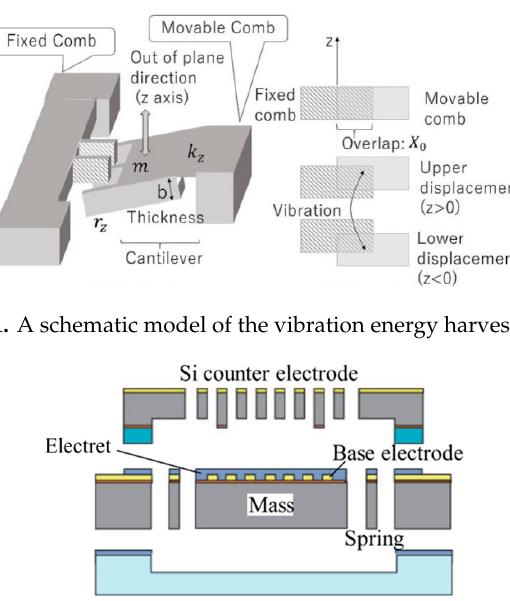
Figure 2. Cross-sectional view of microelectromechanical systems (MEMS) vibration energy harvester.